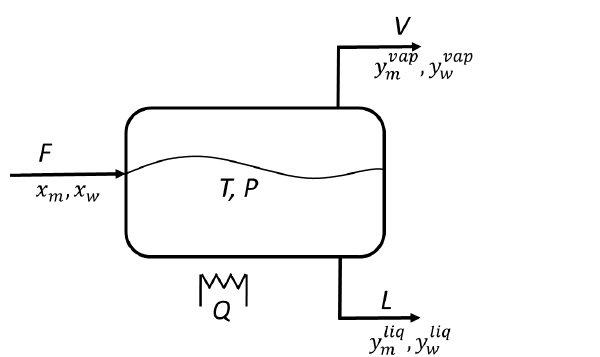
Figure 3. Scheme of the